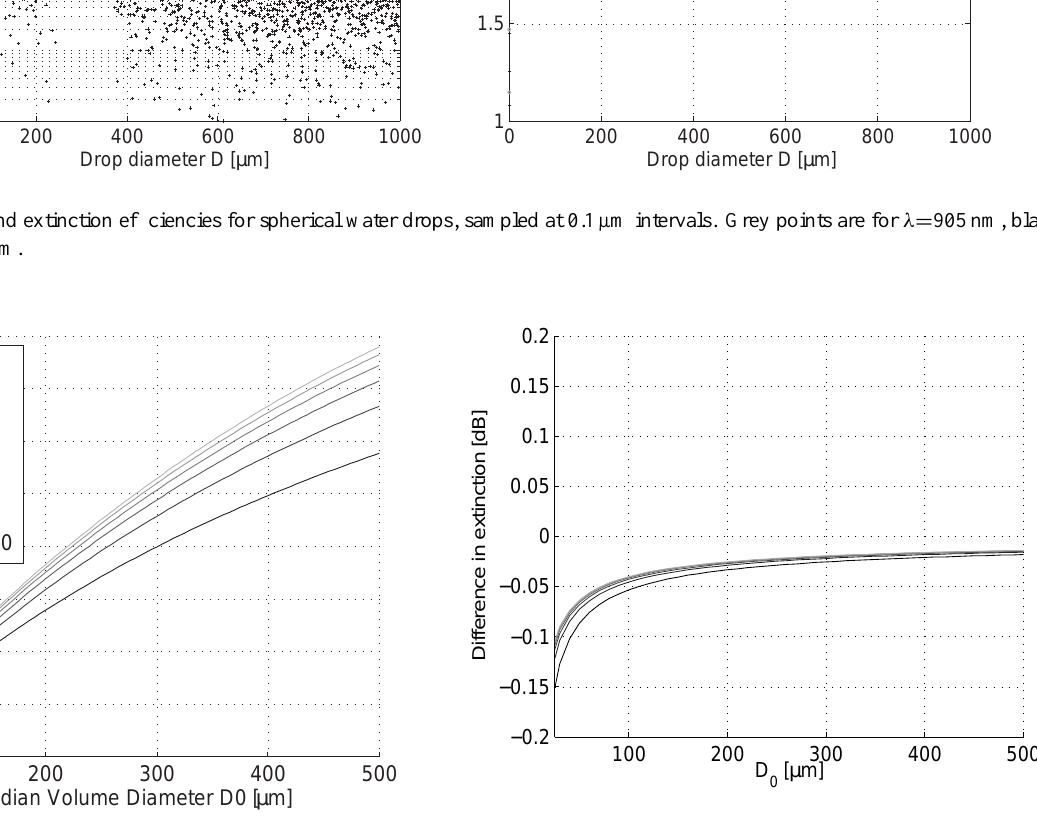
. Values of µ are the same as figure 2. 0